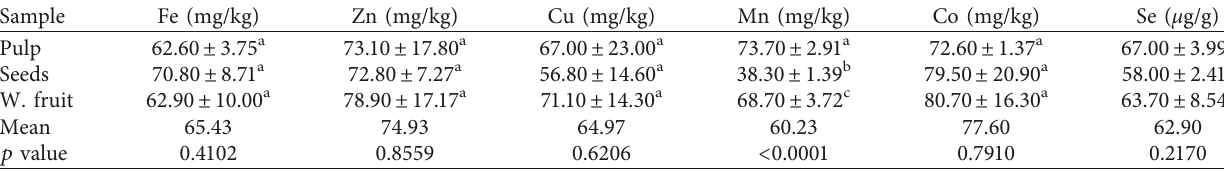
Table 4: Trace elements extractabilities (%) in the fruit of Tetrapleura tetraptera .